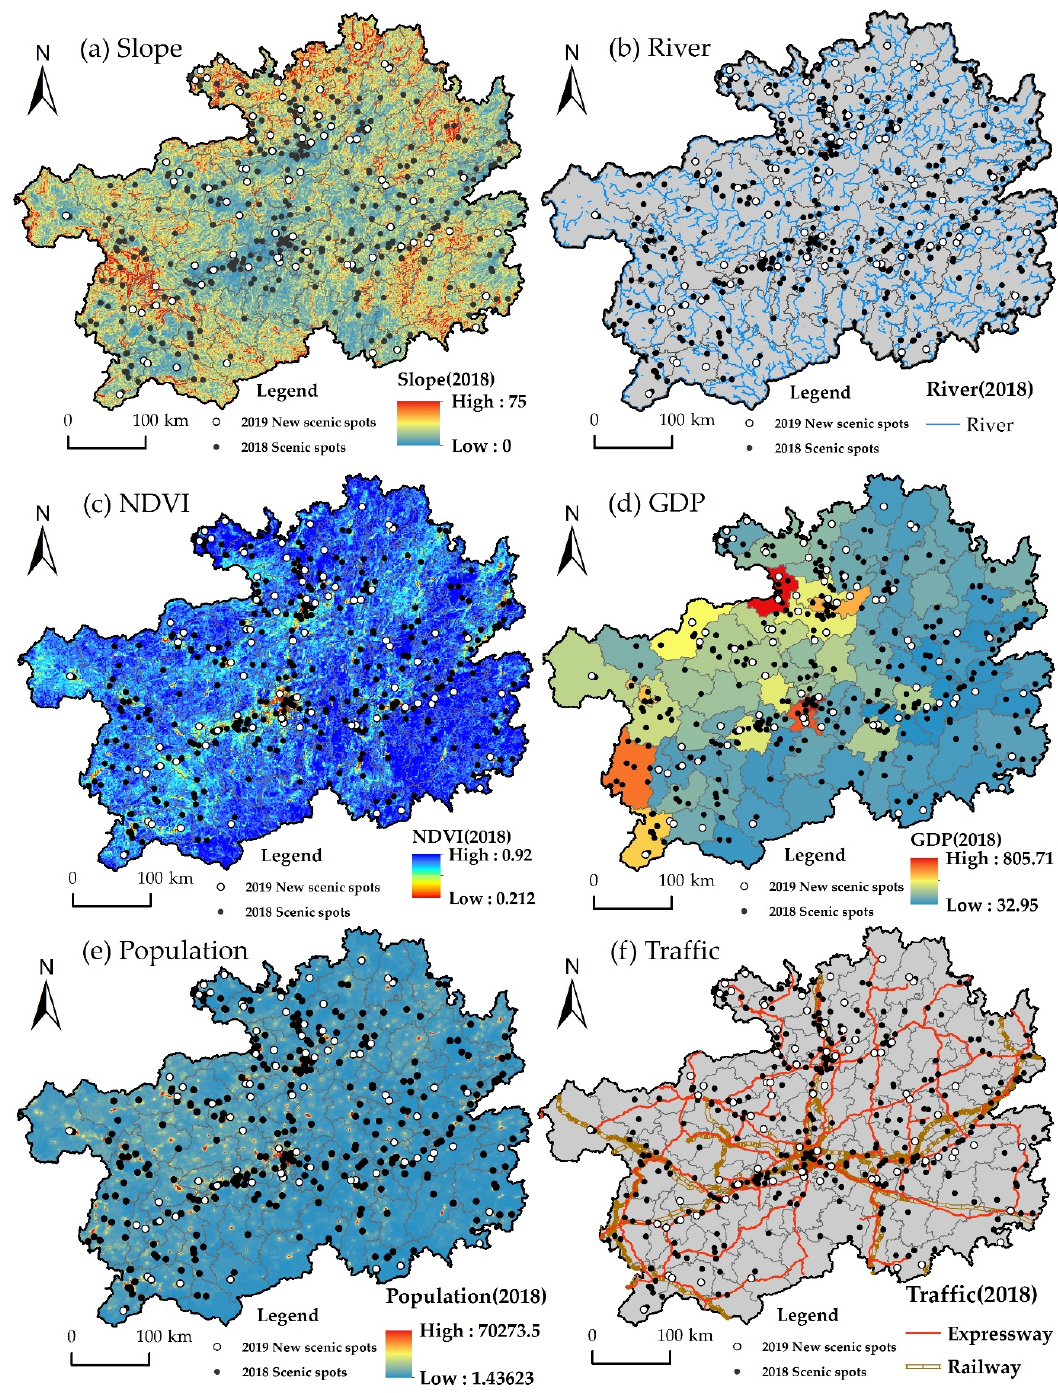
Figure 9. The typical factors influencing the spatial distribution of A-level scenic spots in Guizhou, ( a ) Slope, ( b ) Rivers, ( c ) NDVI, ( d ) GDP, ( e ) Population, ( f )